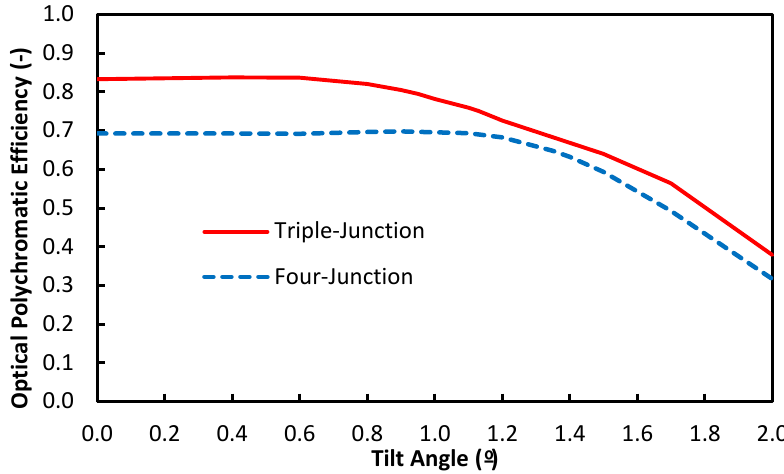
Figure 5. Optical polychromatic efficiency of the two units with different solar cells.